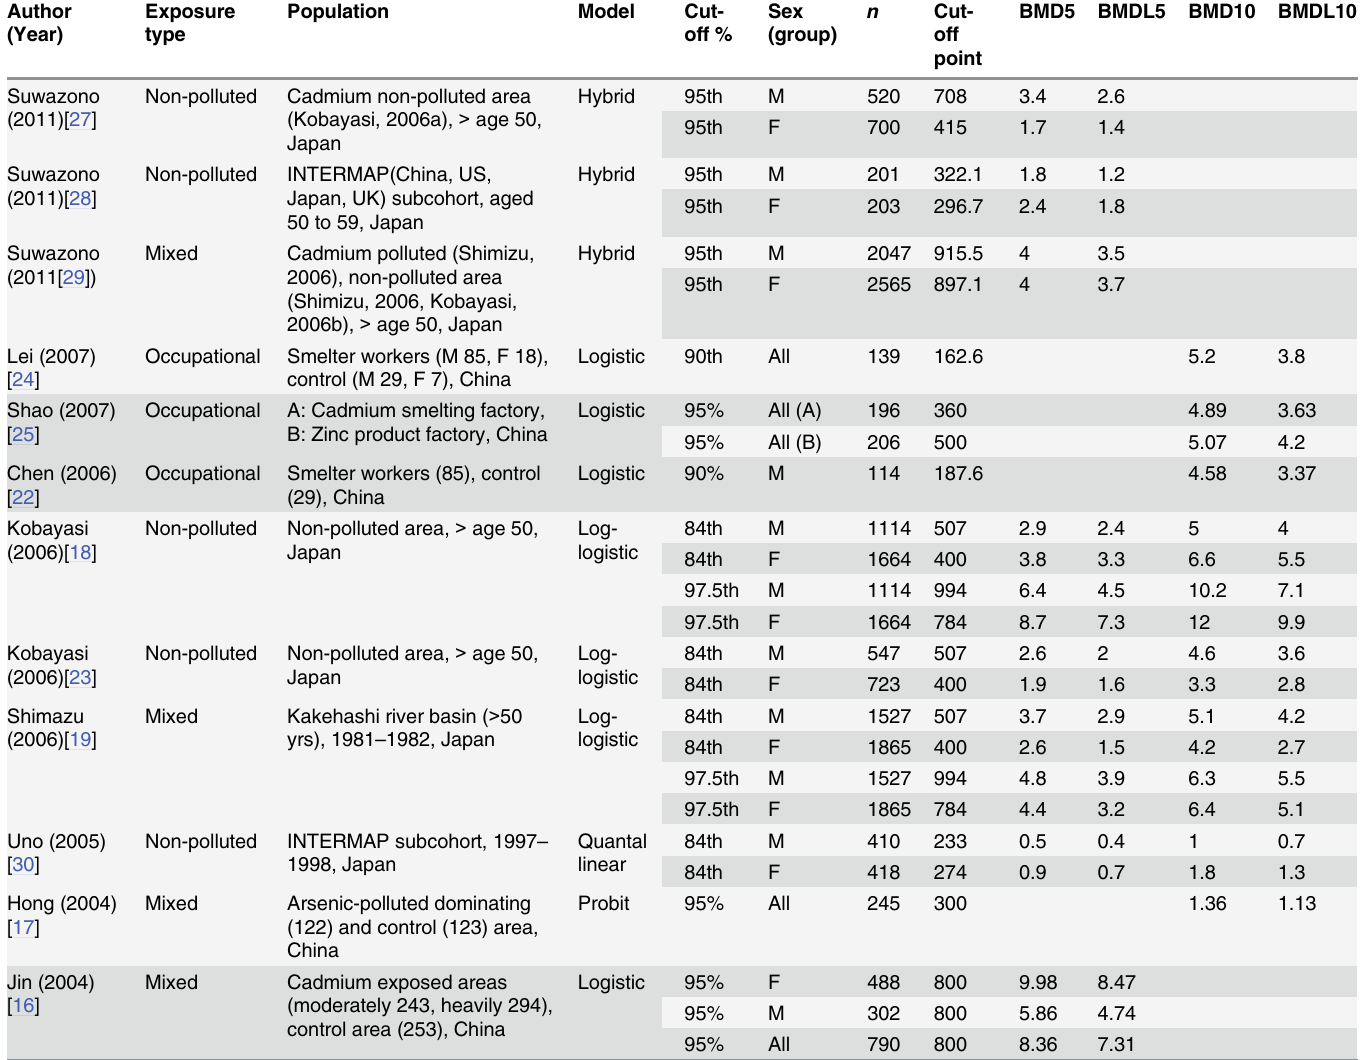
Table 1. Studies reporting benchmark dose for cadmium-induced β